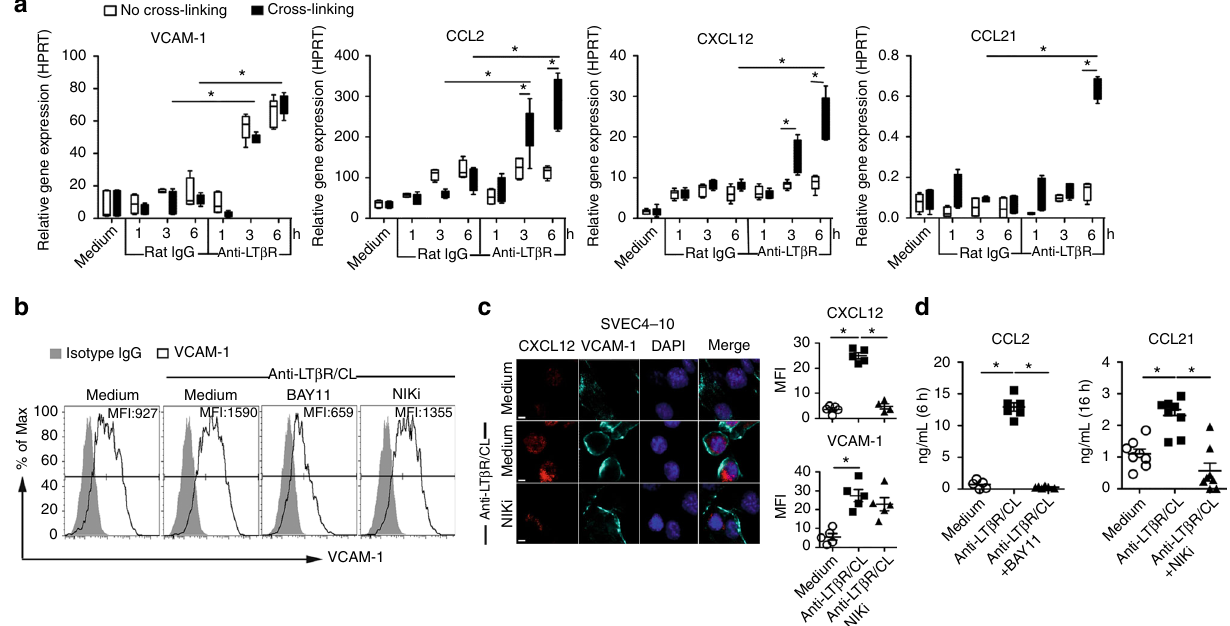
Fig. 2 Agonistic anti-LT β R mAb induces in fl ammatory and homeostatic chemokines and cell adhesion molecules in LEC. a qRT-PCR of indicated genes induced by agonistic anti-LT β R mAb or isotype rat IgG crosslinked with or without mouse anti-rat IgG1 in LEC at the indicated times. Treated as in Fig. 1. b Flow cytometry analysis of VCAM-1 expression on LEC after treatment with anti-LT β R mAb plus crosslinking, with or without 25 μ M NF κ B inhibitor BAY11-7085 or 50 μ M NIKi for 3 h. c LT β R-induced CXCL12 and VCAM-1 expression on SVEC4-10 treated with anti-LT β R mAb plus crosslinking, with or without NIKi (50 μ M) for 3 h. Magni fi cation ×60; scale bar 5 μ m. d Secretion of CCL2 and CCL21 by LEC stimulated with anti-LT β R mAb plus